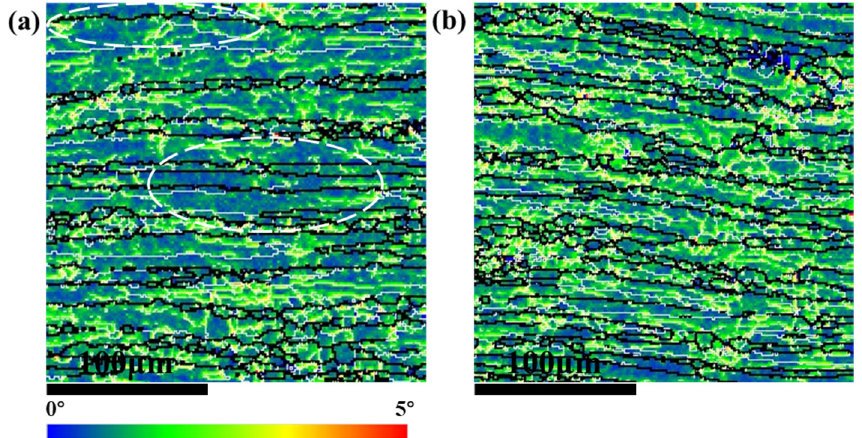
Figure 13. KAM maps showing the local misorientation gradients on the surface of the Cl sample of TDSP tensioned to 0.12 strain at ( a ) 25 °C and ( b ) − 196 °C.